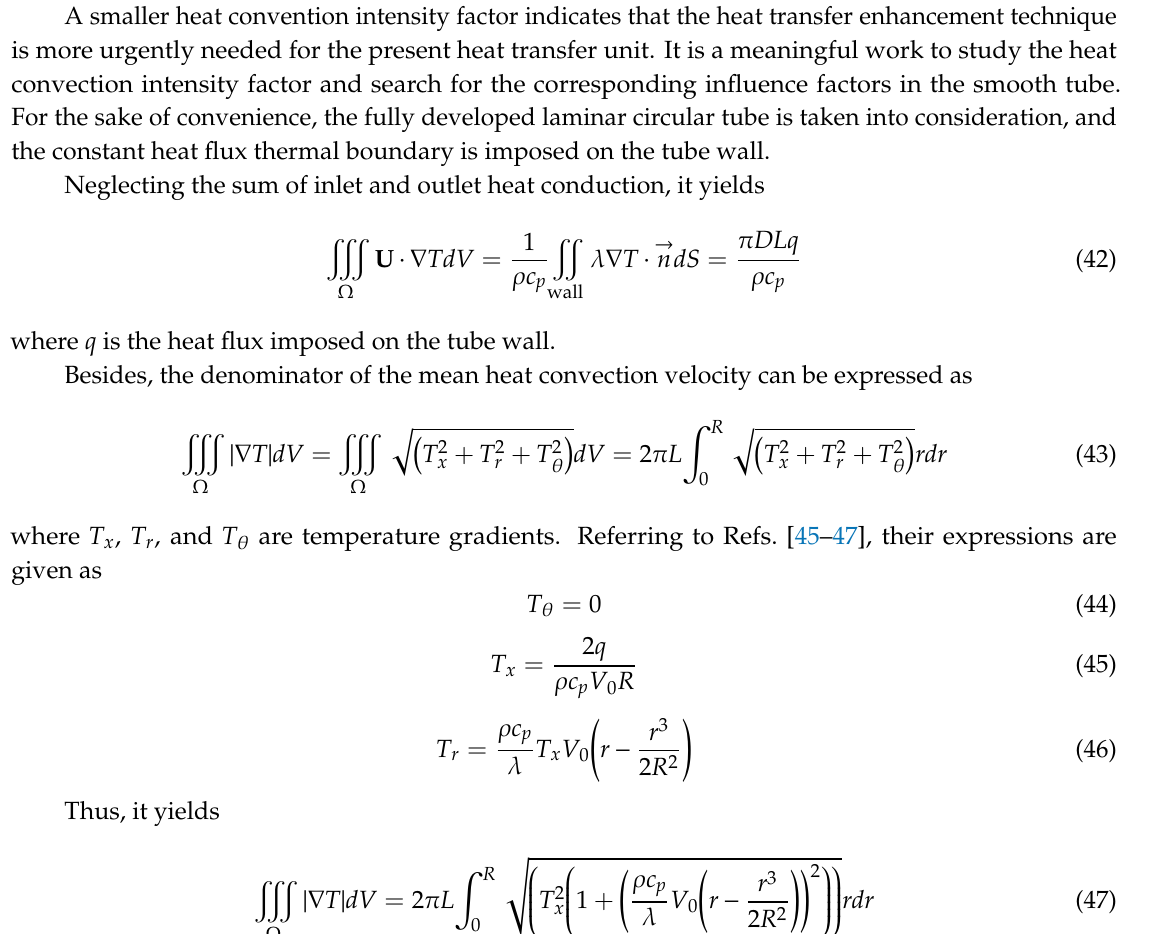
Figure 9. The variation of Nusselt number ( a ) and heat convection intensity ( b ) along the tube under the constant wall temperature